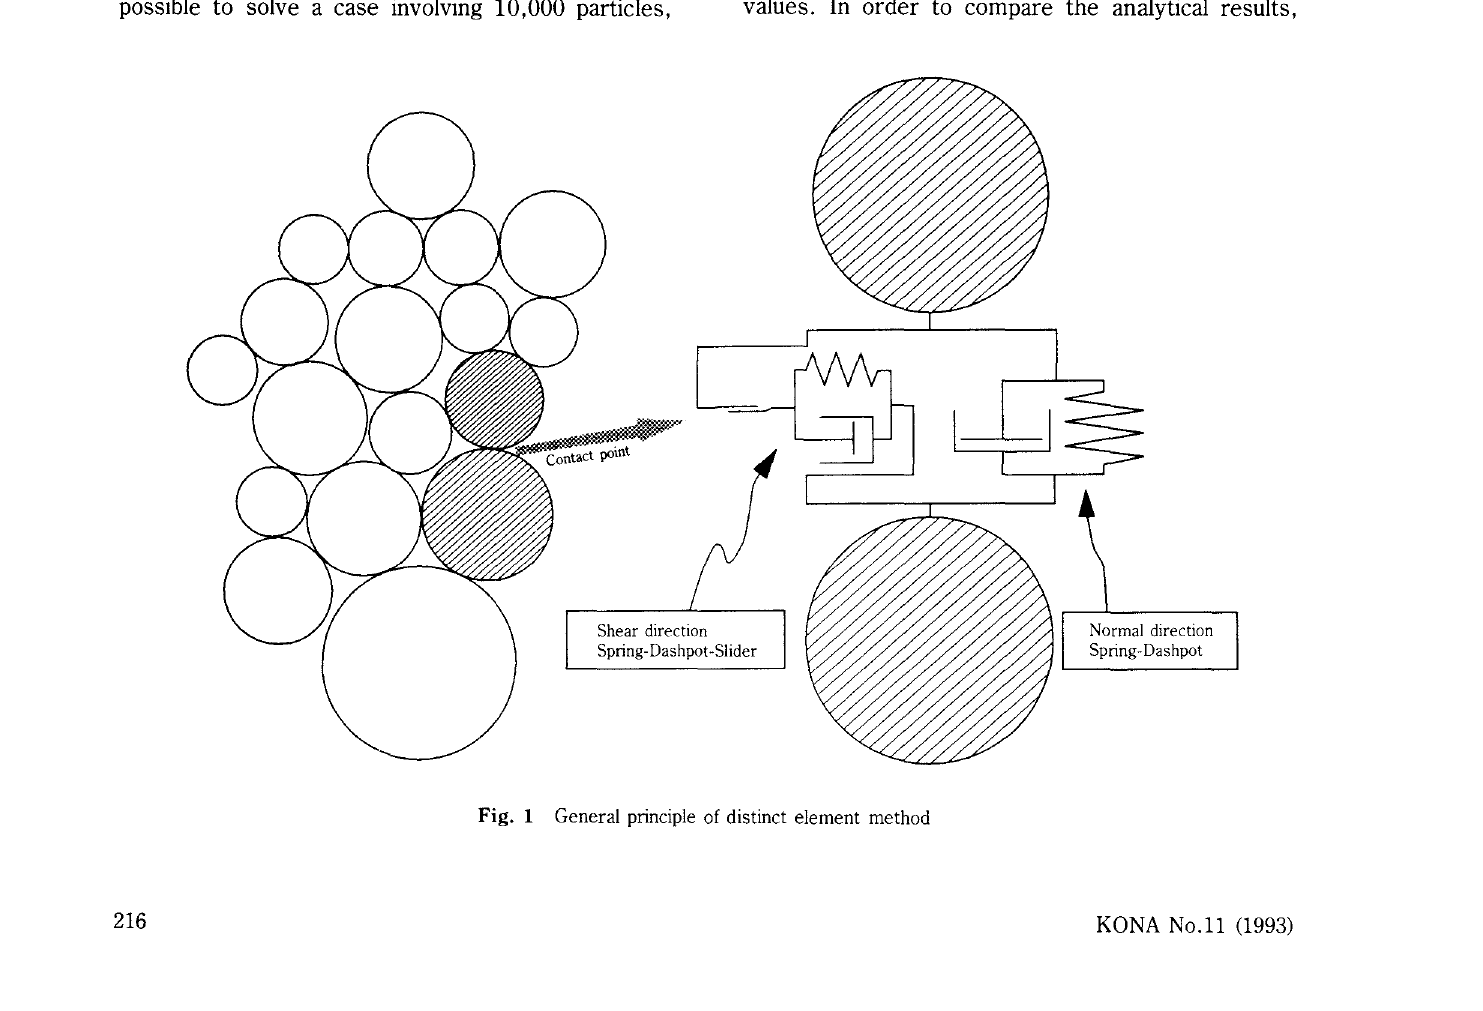
Fig. 1 General principle of distinct element